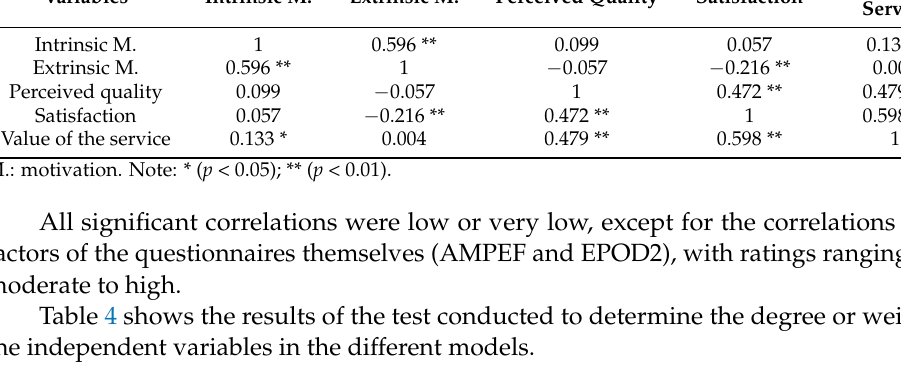
Table 4. Test coefficients for the AMPEF and EPOD2 questionnaire factors. Dependent